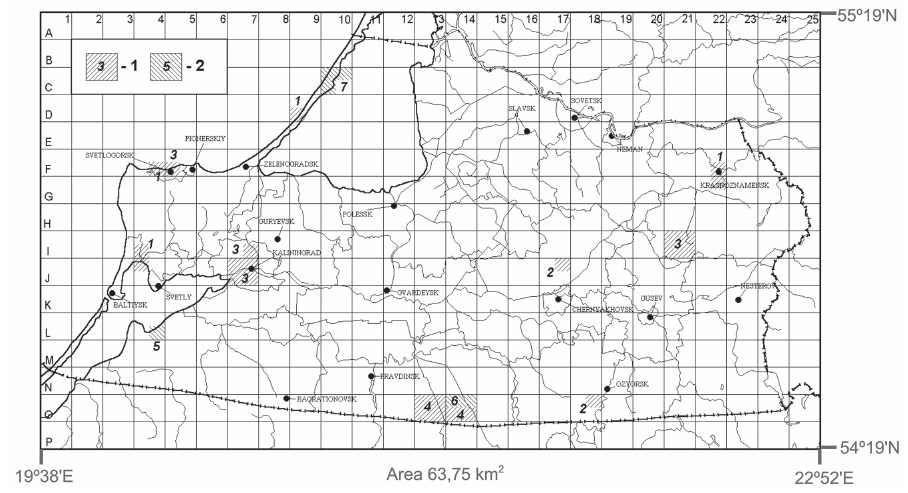
Figure 13. The plant species distribution for which there is a threat of extinction in the range. A species that are threatened with extinction in the range (under natural protection, category I) B species that are under international protection. The numbers designate the species: 1 Botrychium simplex E. Hitchc. 2 Orchis mascula L. 3 Taxus baccata L., 4 Gladiolus palustris Gaudin 5 Cypripedium calceolus L. (IUCN Red Book) 6 Epipogium aphyllum Sw. (Convention on International Trade in Endangered Species of Wild Fauna and Flora) 7 Orchis morio L. (Convention on International Trade in Endangered Species of Wild Fauna and